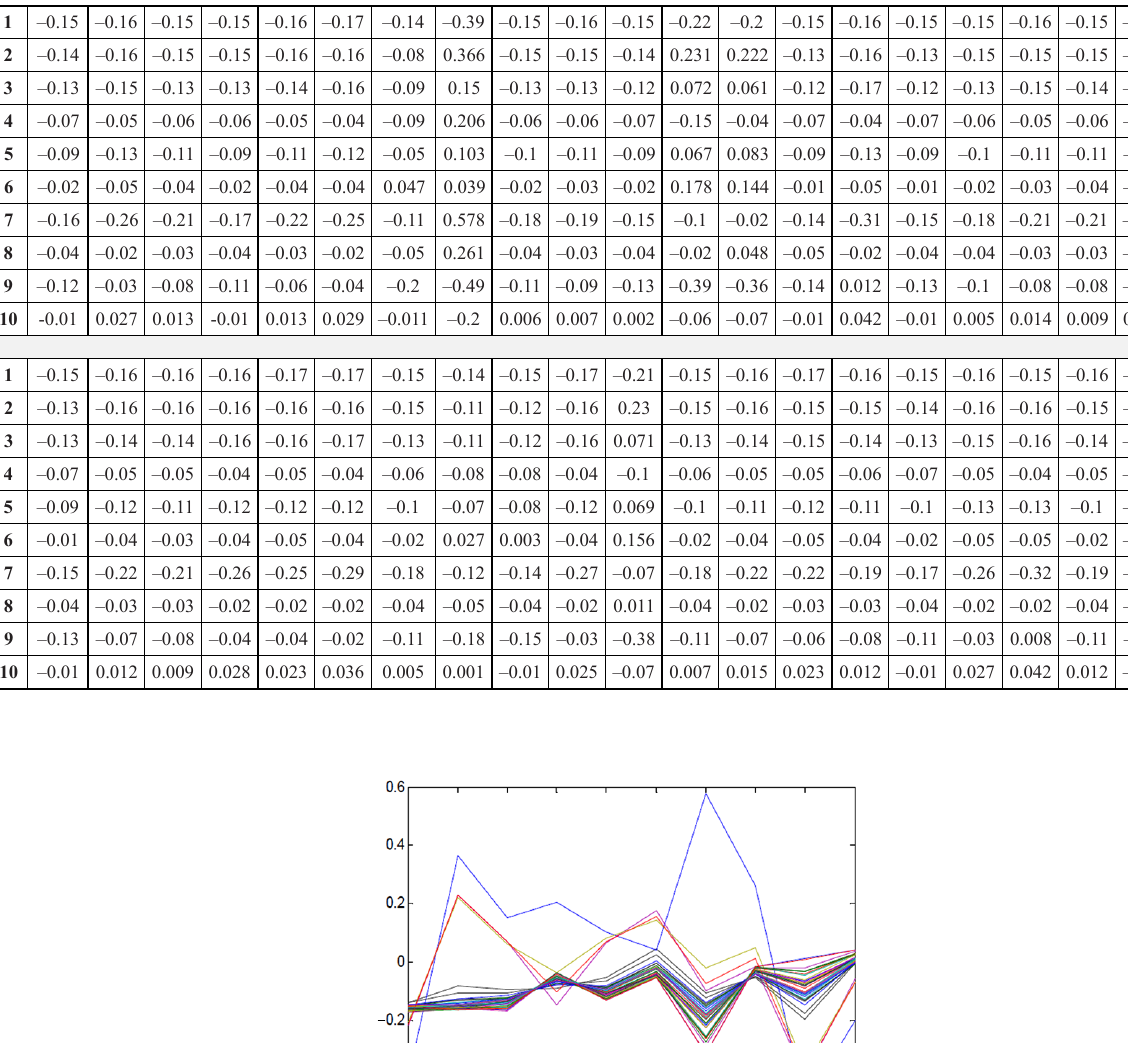
Table 1A. The weights used in the first and second intermediate layers based on epochs Conditions and Randperm function